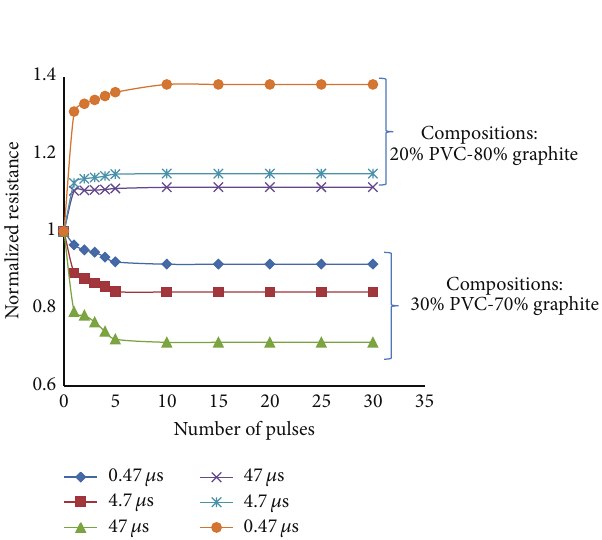
Figure5:Normalizedresistancevariationwithnumberofpulsesfor different